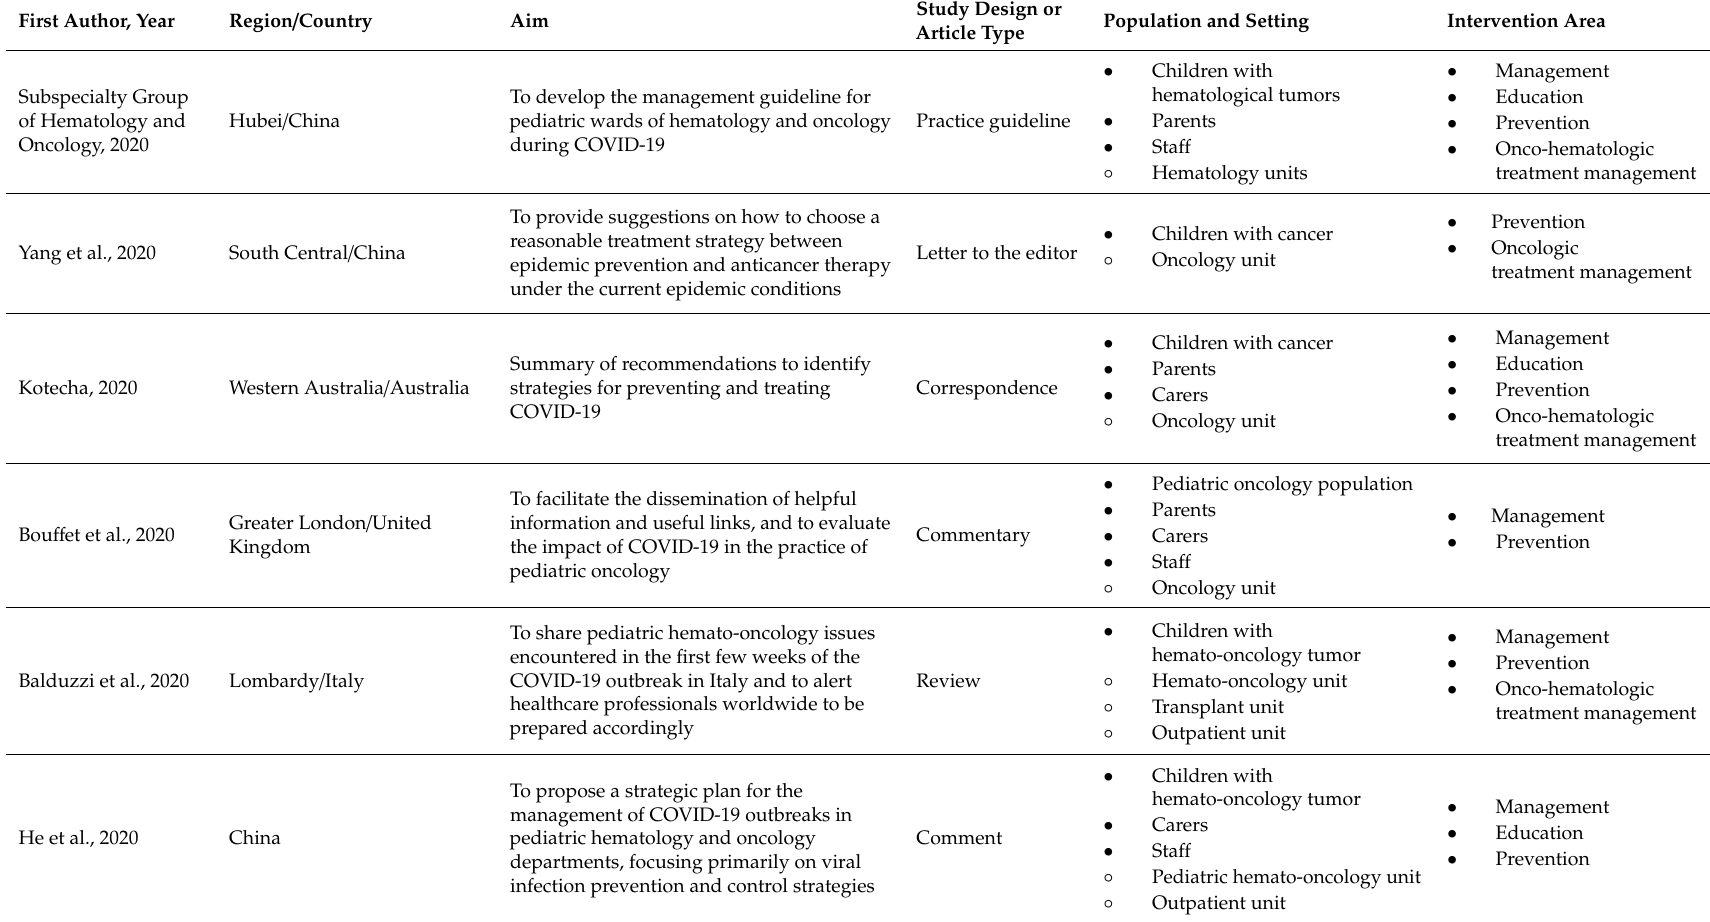
Table 1. Date extraction of the included